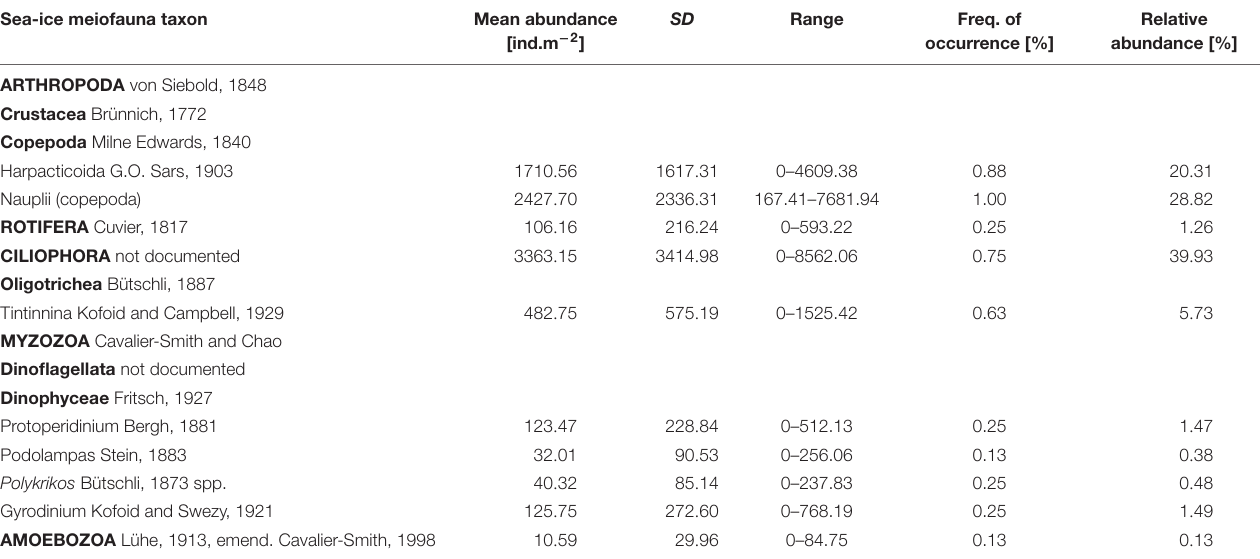
TABLE 3 | List of sea-ice meiofauna taxa with mean abundance and frequency of occurrence across the sample area. Sea-ice meiofauna taxon